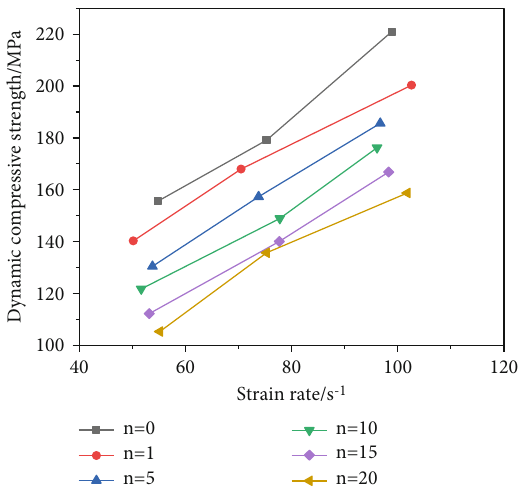
Figure 6: Dynamic axial strain of sandstone under di ff erent strain rates.